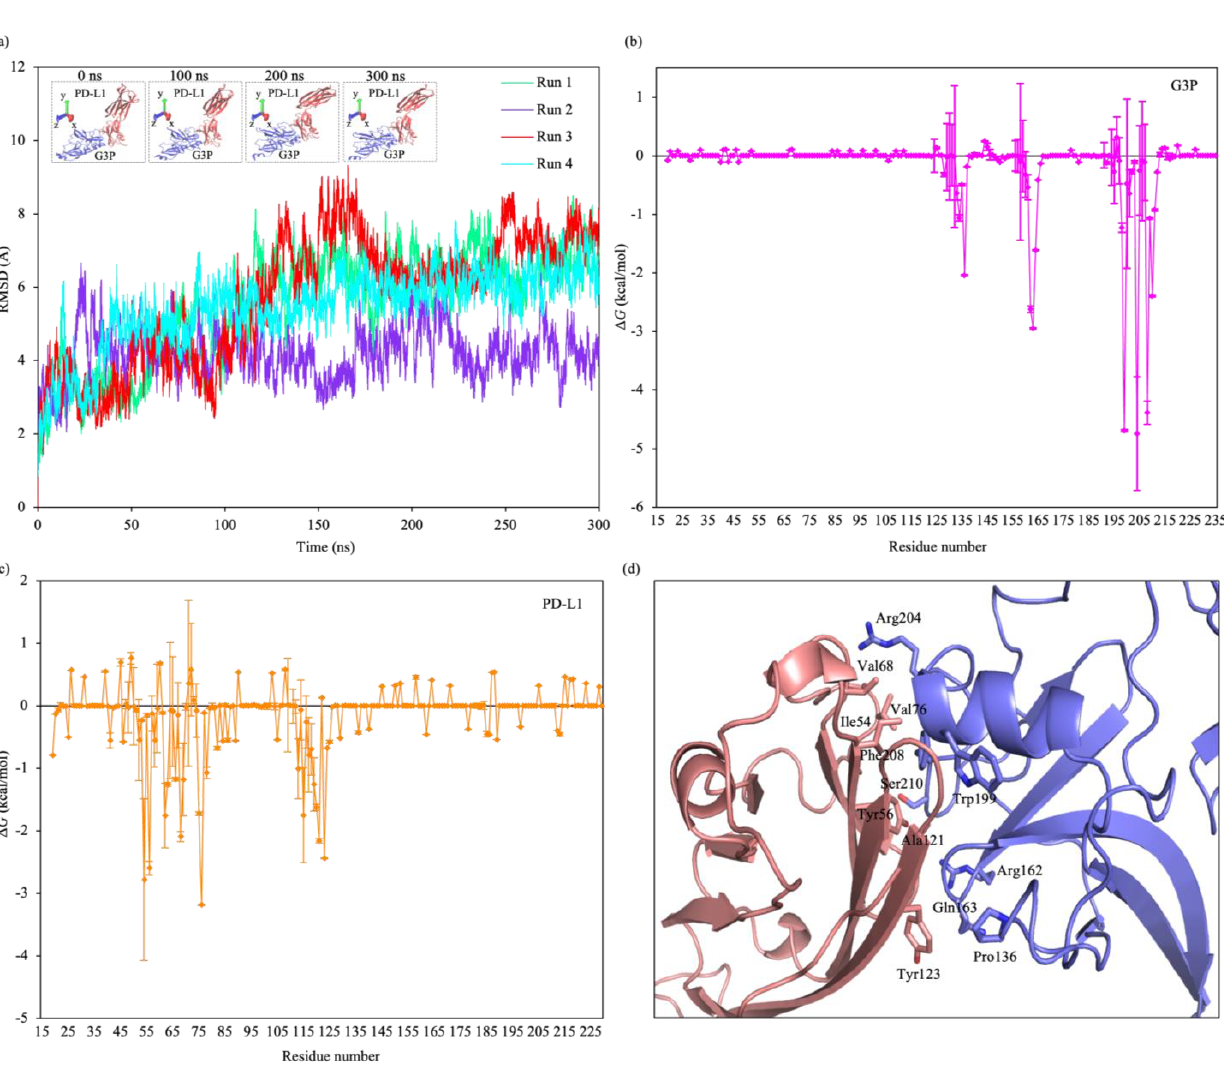
Figure 2. MD simulations. ( a ) Time evolution of the RMSD of backbone atoms of the M13 G3P–PD-L1 protein–protein complex. Inset, snapshots of the M13 phage protein G3P and cancer cell protein PD-L1 for different periods of run 1. ( b , c ) Binding free energy contributions of the ( b ) G3P and ( c ) PD-L1 residues. ( d ) Binding interface of the G3P–PD-L1 complex (purple, G3P; pink, PD-L1). The major interacting residues are shown in sticks.